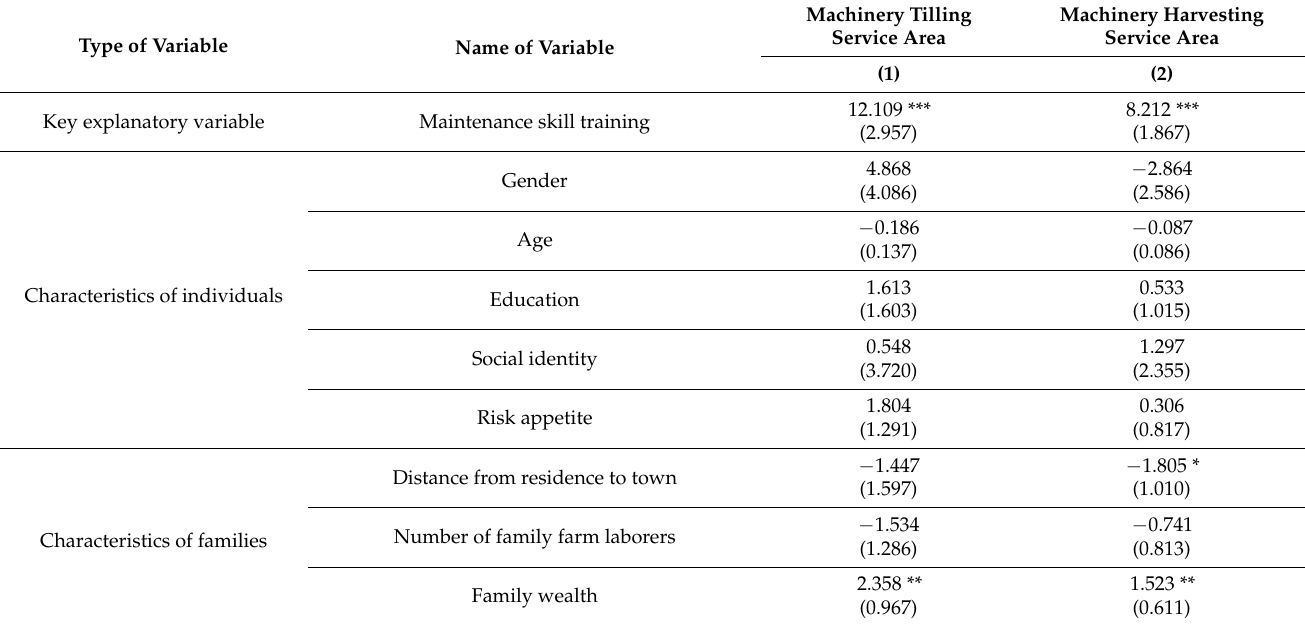
Table 2. Results of fixed effect model (agricultural machinery operation service